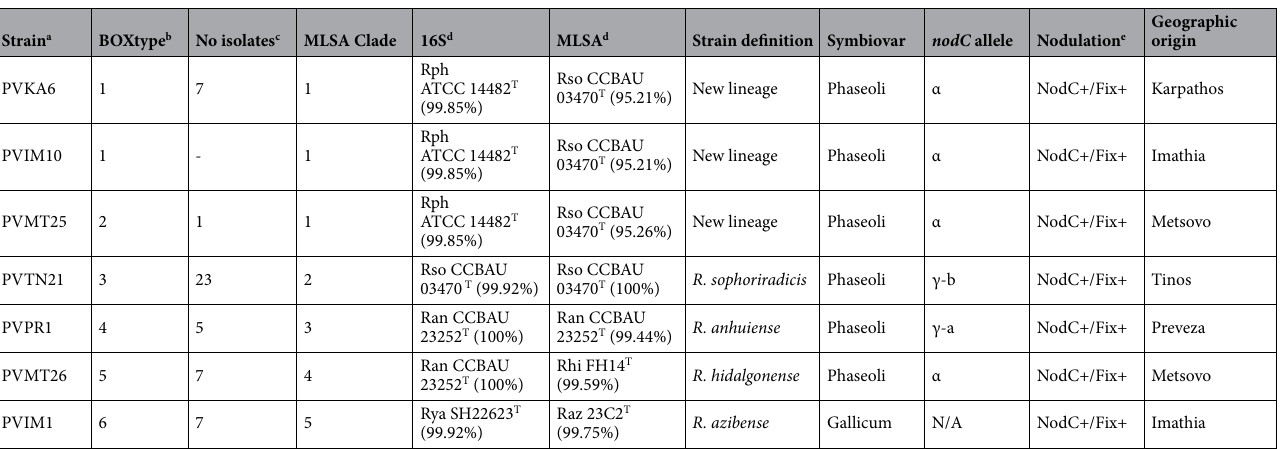
Table 1. Characteristics of rhizobial strains obtained in this study and their phylogenetic relationships with the closest type species. Ran, Rhizobium anhuiense ; Raz, Rhizobium azibense , Rhi, Rhizobium hidalgonense ; Rph, Rhizobium phaseoli ; Rso, Rhizobium sophoriradicis ; Rya, Rhizobium yanglingense ; N/A not applicable. a Representative isolates from different BOX-groups and geographic regions. b Different numbers were assigned to represent each BOX-PCR pattern. c Number of isolates displaying identical BOX-PCR pattern. d Percent identities determined by multiple sequence alignments of partial gene sequences using the algorithm CLUSTAL Omega at https:// www. ebi. ac. uk/ Tools/ msa/ clust alo/. e Nodulation was tested on common bean, the host of origin for each